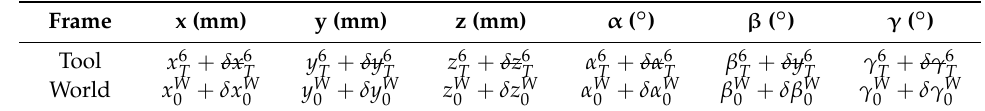
Table 6. Tool and base calibration